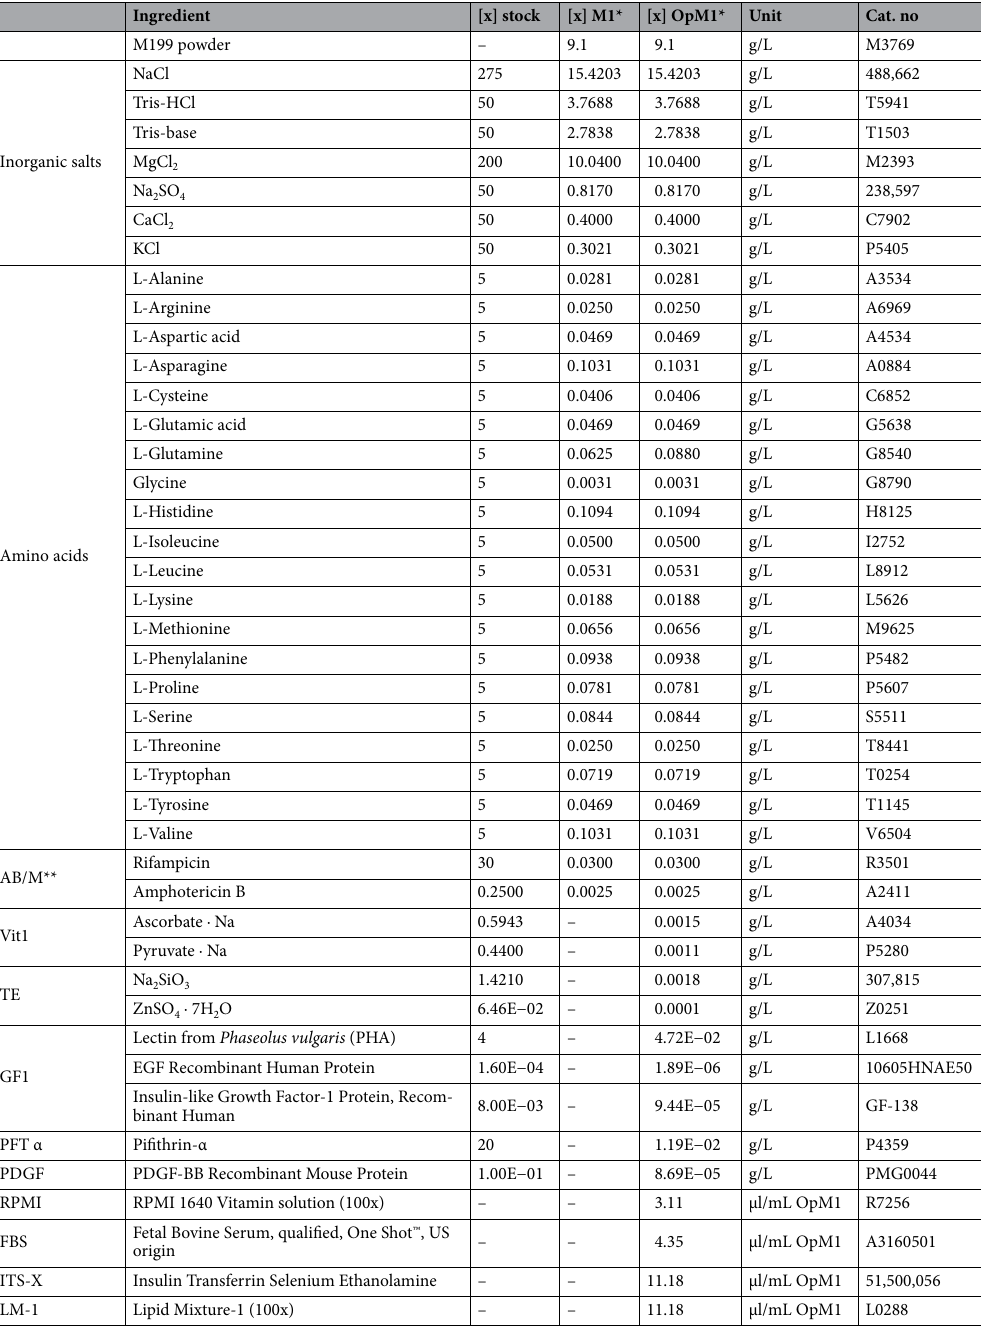
Table 1. Compositions of M1 and OpM1 media. *Numbers in columns [x] M1 and [x] OpM1 do not include concentrations of nutrients present in M199 powder, only what is added to prepare both media. **Antibiotics and